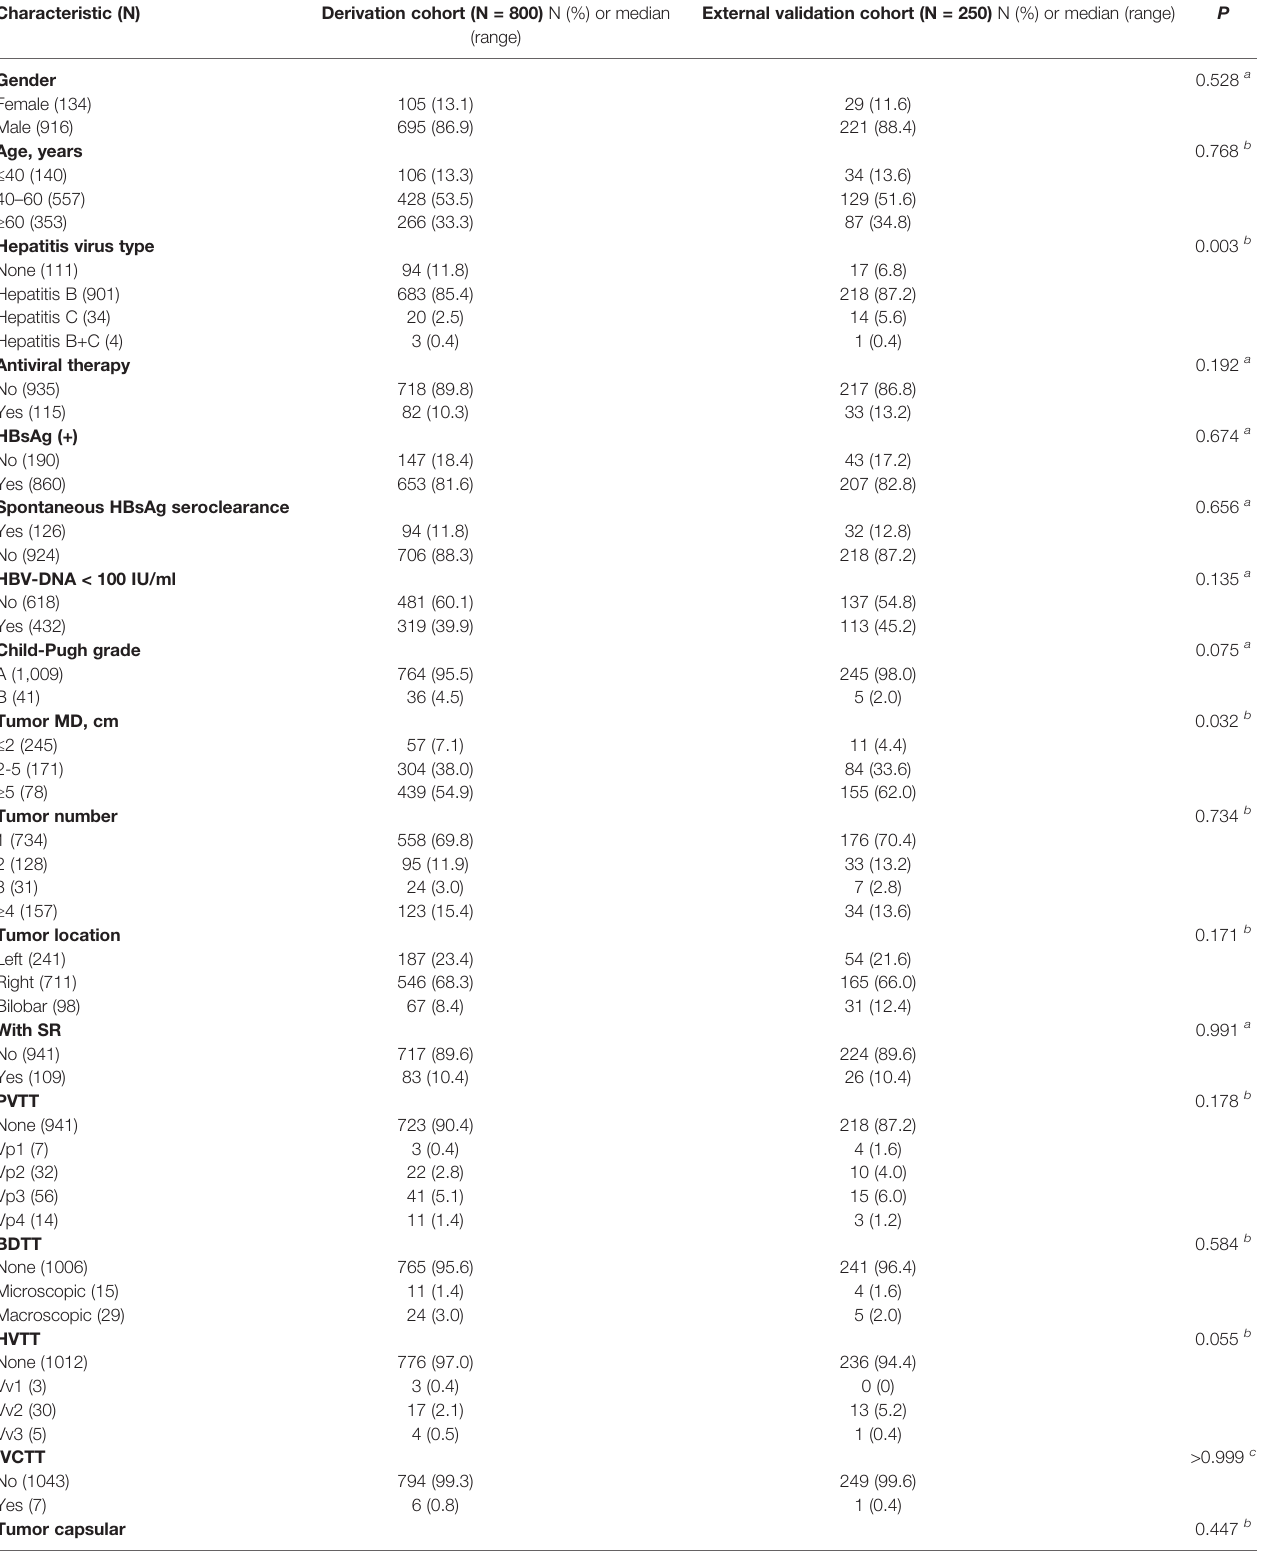
TABLE 1 | Demographic and clinicopathological characteristics of the derivation and external validation